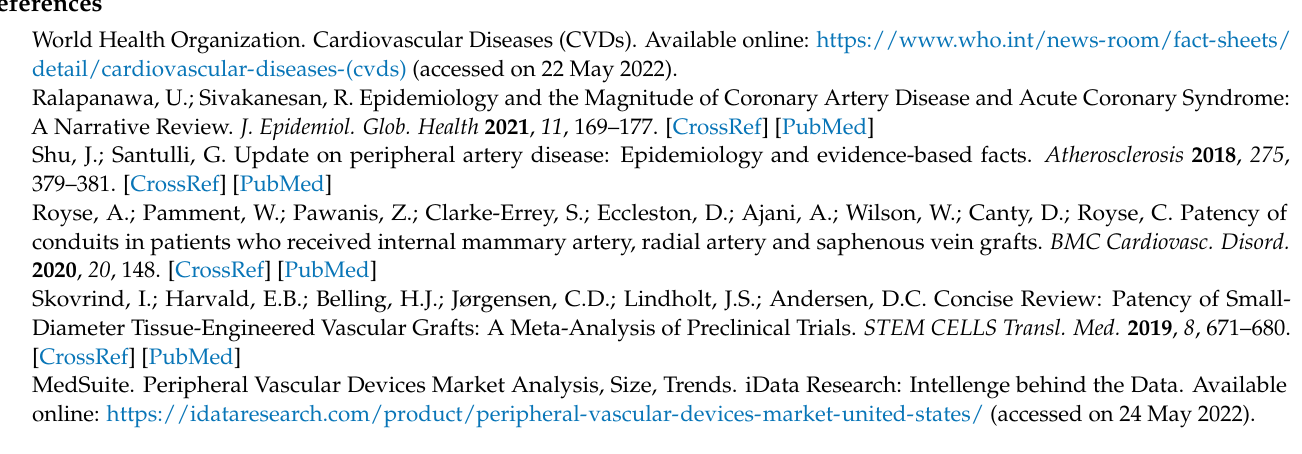
trials; Figure S2: PRISMA algorithm for in vitro trials; Tables S1–S3: Summary tables of descrip- tive analysis; Tables S4–S26: Tables from descriptive analysis of pre-clinical trials; Tables S27–S42: Tables from descriptive analysis of in vitro tested